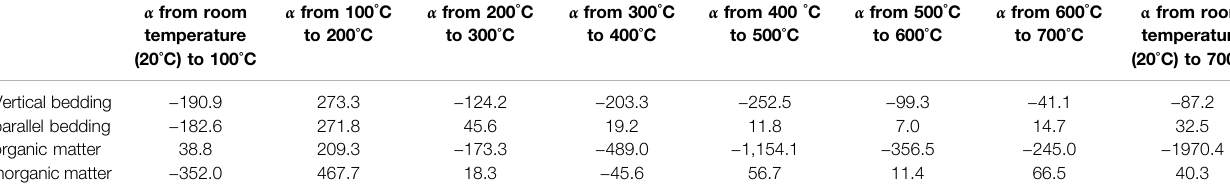
TABLE 1 | The coef fi cient of linear thermal expansion values ( α ) at various temperatures ( × 10 – 6 C). α from room